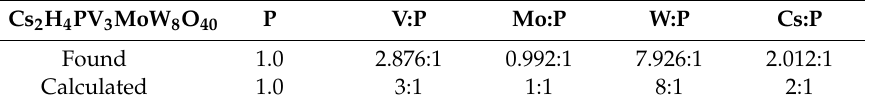
Table 1. Elemental compositions for the Cs 2 H 4 PV 3 MoW 8 O 40 catalysts determined by plasma–atomic emission spectrometry techniques.